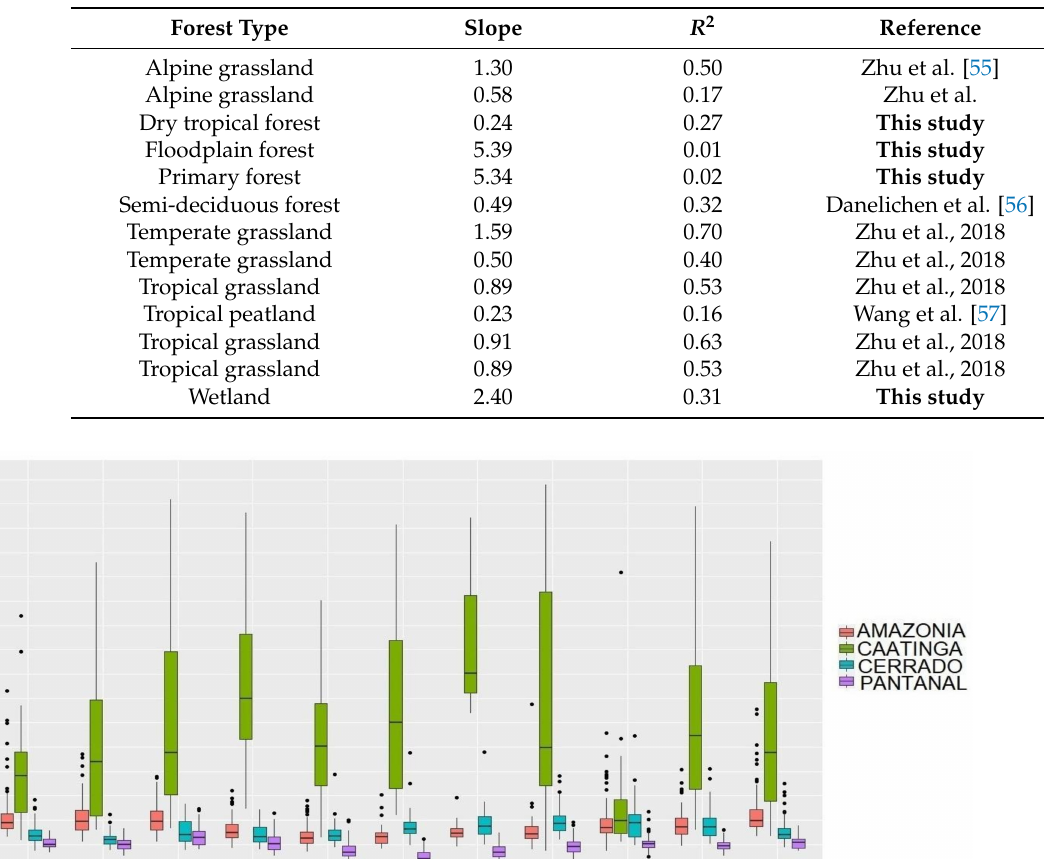
Table 1. Statistical summary of studies comparing MODIS GPP and eddy covariance estimations for different land covers using linear regression models.